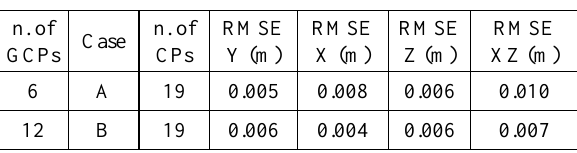
Table 2. RMSE in Constrained Solution